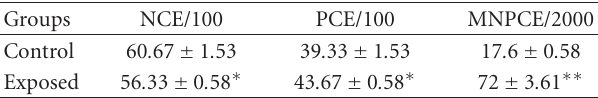
Table 3: Micronucleus induction (MNPCE), PCE, and NCE in bone marrow cells of control newborn rats and those exposed to 50Hz and 0.5 mT MF for 30 days 24 h/day. Each value was expressed as mean of 10 rats ± standard error.